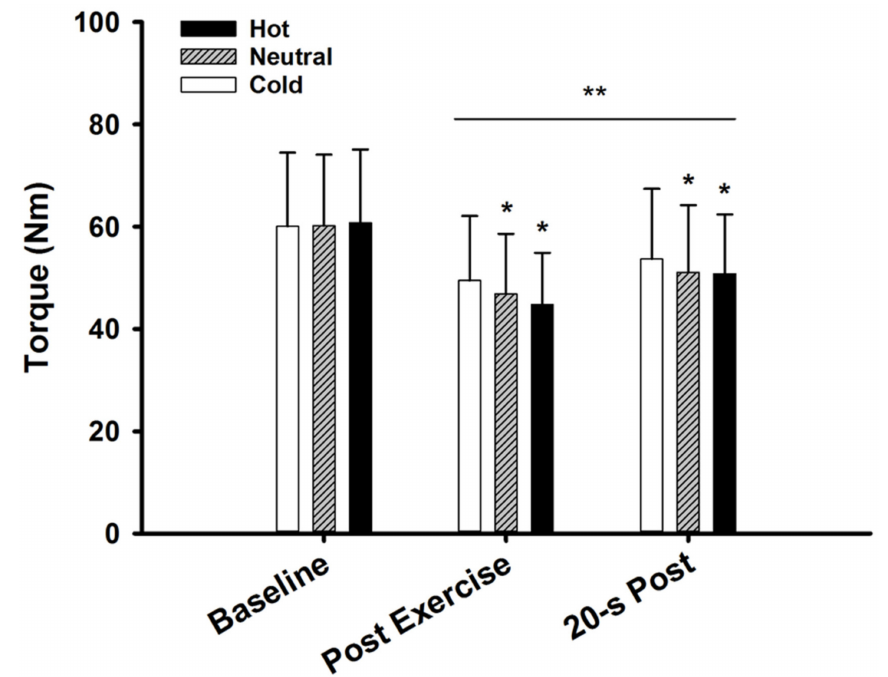
Figure 2. MVIC torque throughout testing (Baseline), MVIC at the end of the fatiguing task (Post Exercise), and 20 s post fatiguing task (20-s Post). * ( p < 0.05) vs. cold. ** ( p < 0.05) vs.